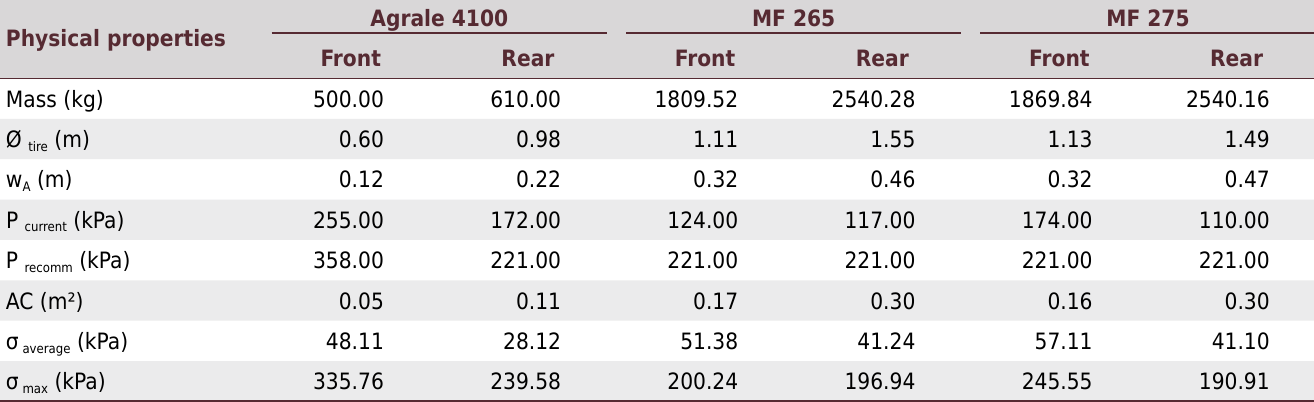
Table 3. Physical properties, contact area, average and maximum vertical stress of the agricultural tractors Agrale 4100, MF 265 and MF 275 used in the agricultural activities of the experimental area Agrale Physical properties